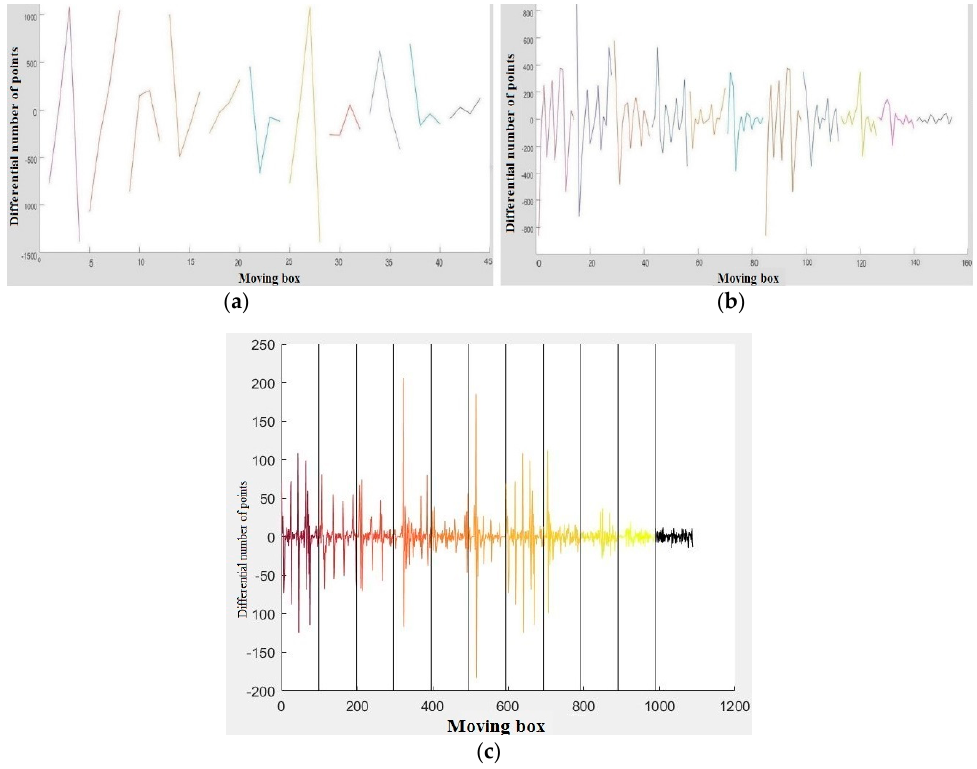
Figure 12. Differential number of points for consecutive sub-segments of window and non-window patches employing, ( a ) 5 steps, ( b ) 15 steps, and ( c ) 40 steps.